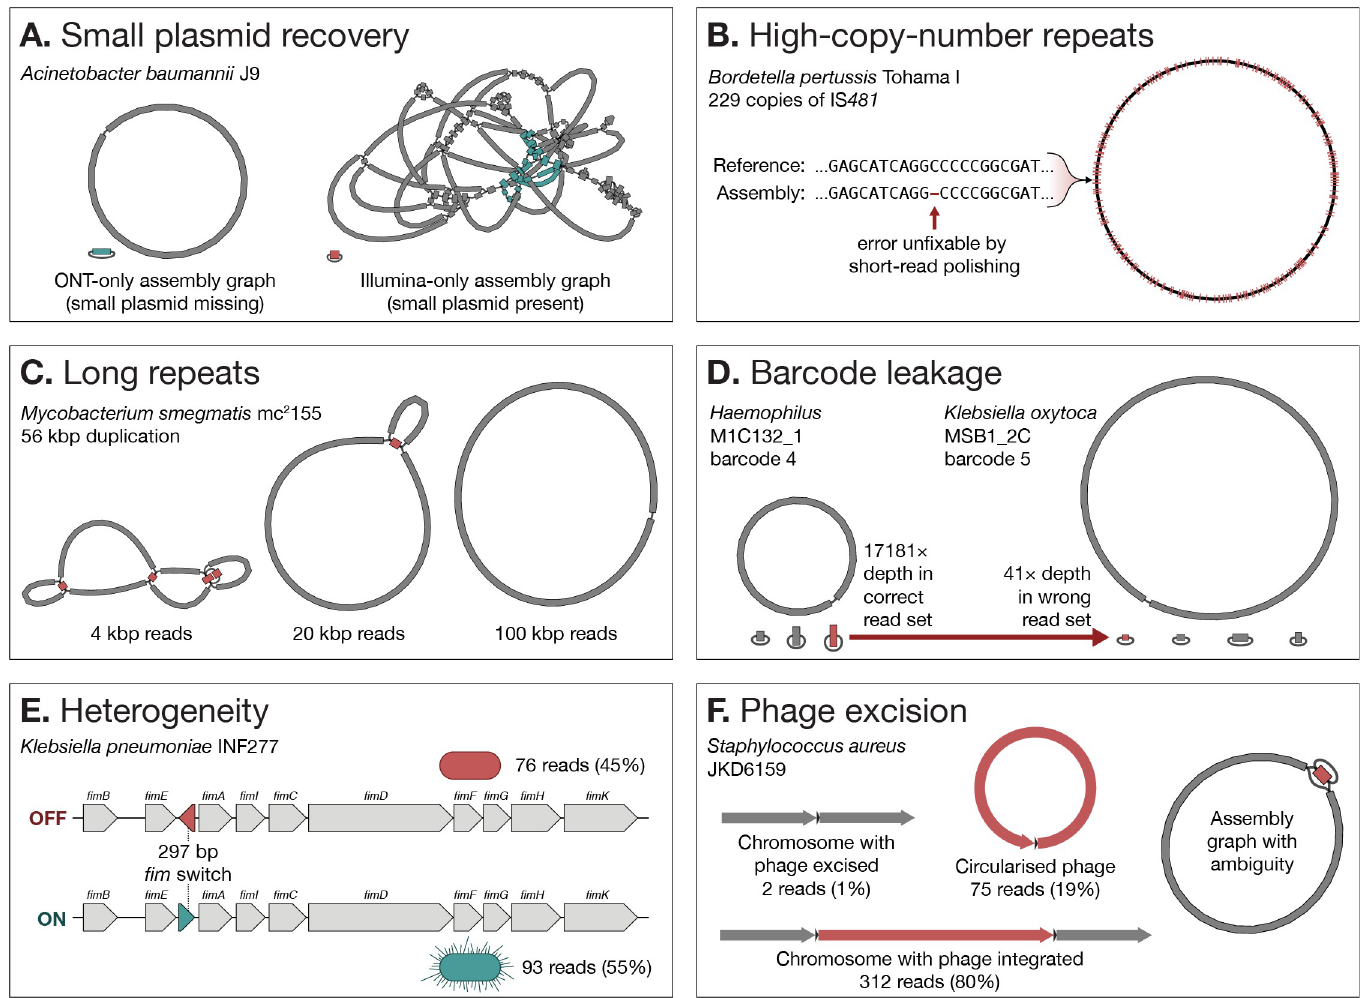
Fig 2. Examples of pitfalls in bacterial genome assembly and polishing. ( A) A . baumannii J9 [47] contains one large 145-kbp plasmid (blue) and one small 6-kbp plasmid (red). The small plasmid is missing from an ONT-only assembly of this genome (left). However, it assembled completely in an Illumina-only assembly (right), enabling its recovery. ( B) IS 481 is a repeat in the B . pertussis Tohama I genome [53]. Due to its high copy-number, some errors in this repeat are not fixable using paired- end Illumina reads and short-read polishers. ( C) If a genome contains a very long repeat, as is the case with M . smegmatis mc 2 155 [51], typical ONT read lengths of approximately 20 kbp may not be sufficient for complete assembly. ( D) As occurred with Haemophilus M1C132_1 and K . oxytoca MSB1_2C [6], read demultiplexing errors can cause a deeply sequenced replicon in one genome (left) to erroneously appear in the assembly of another genome from the same sequencing run (right). ( E) ONT sequencing of K . pneumoniae INF277 [54] contained a near-50:50 mixture of fim switch orientations, causing problems during long-read and short-read polishing. ( F) S . aureus JKD6159 [7] read sets contained structural heterogeneity around the F Sa3 bacteriophage sequence (left), causing an incomplete Flye assembly graph (right).